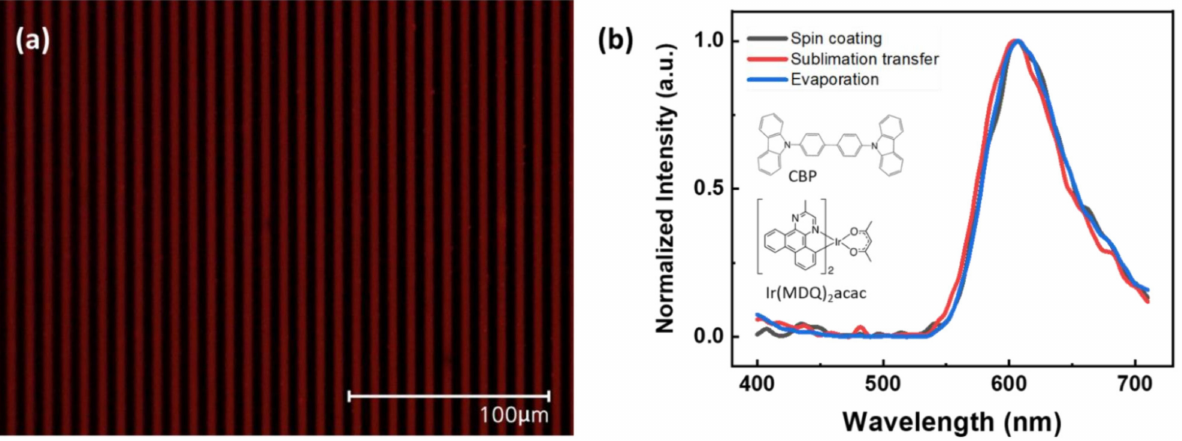
Figure 8. ( a ) OM image with UV exposure of sublimation transferred pattern. ( b ) Normalized PL spectra at an excitation wavelength of 365 nm, according to the patterning methods; sublimation transfer, evaporation, and spin-coating. Insets are the chemical structure of the emitting materials; CBP and Ir(MDQ) 2